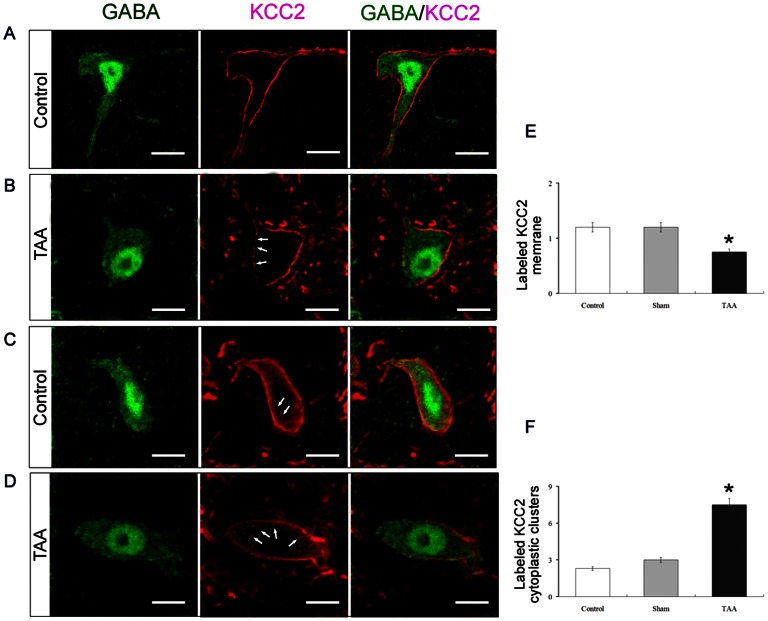
Reduced targeting of KCC2 to membrane of GABAergic neuron within the SNr following TAA treatment.(A–D) Results of immunohistochemical staining with a KCC2 - specific antibody (red) in SNr GABAergic neurons (green) of control and TAA mice. Single optical sections showing normal KCC2 staining and the discontinuous clusters of stained spots (arrows) in GABAergic neuron membranes of control (A) and TAA (B) mice. Single optical sections showing the density of cytoplasmic KCC2 - immunolabeled clusters (arrows) in control (C) and TAA (D) mice. (E) Quantification of the density of membrane labeling (ratios of labeled pixel surface per somatic perimeter) in 24 GABAergic neurons from three control mice and 27 GABAergic neurons from three TAA mice. (F) Number of cytoplasmic KCC2-immunolabeled clusters per 100 µm2 of somatic area. GABAergic neurons in both control and TAA mice. Bars in A, B, C and D = 10 µm. * in E and F P<0.05 vs normal controls.